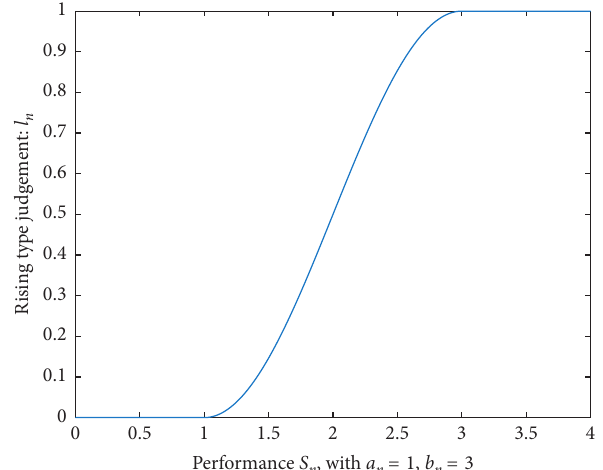
Figure 4: An example of the rising type judgment, where a and b n �